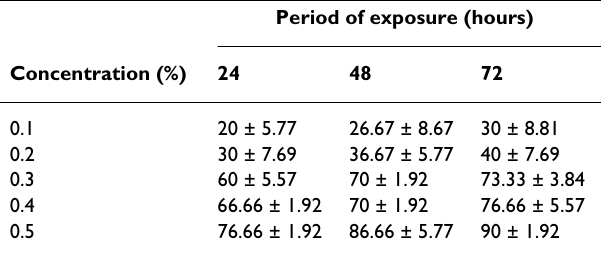
Table 1: The larvicidal activity (mean mortality ± standard error) of different concentrations of aqueous extract of the green berries of S. villosum on third instar larvae of S. aegypti . Student's t -test t = 29.42*, 5.5*, 17.0* (between 0.5% and 0.1%) 12.43*, 3.32*, 14.0* (between 0.5% and 0.2%) and 1.73*, 4.33*, 4.0* (between mortality in 0.5% and 0.3% plant extract at 24, 48 and 72 hours bioassay); * denotes significant ( p < 0.05); table value = 2.92 at five degrees of freedom. M, mortality (%); SE, standard